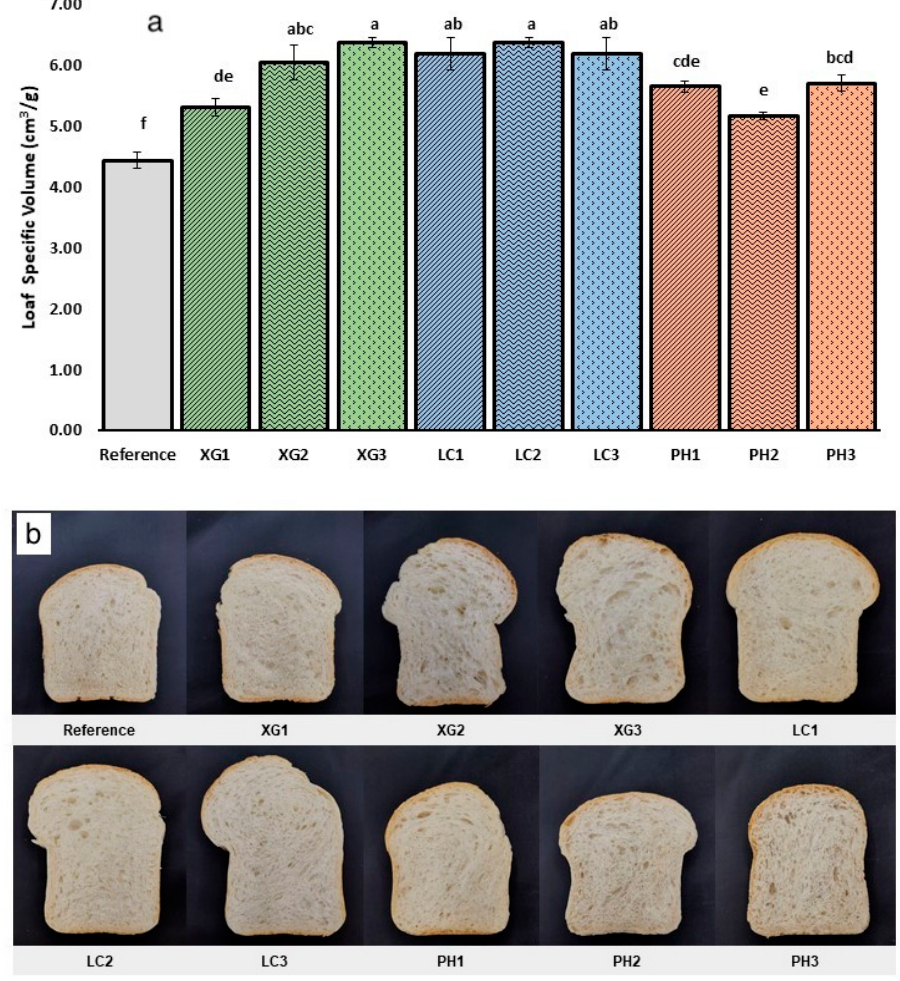
Figure 2. ( a ) Bar graph ( top ). Loaf specific volume across bread formulations. Error bar represents mean ± standard deviation, n = 3. Different letters represent significant difference ( p < 0.05). ( b ) Photographs ( bottom ) indicate the crumb appearance of the bread samples.